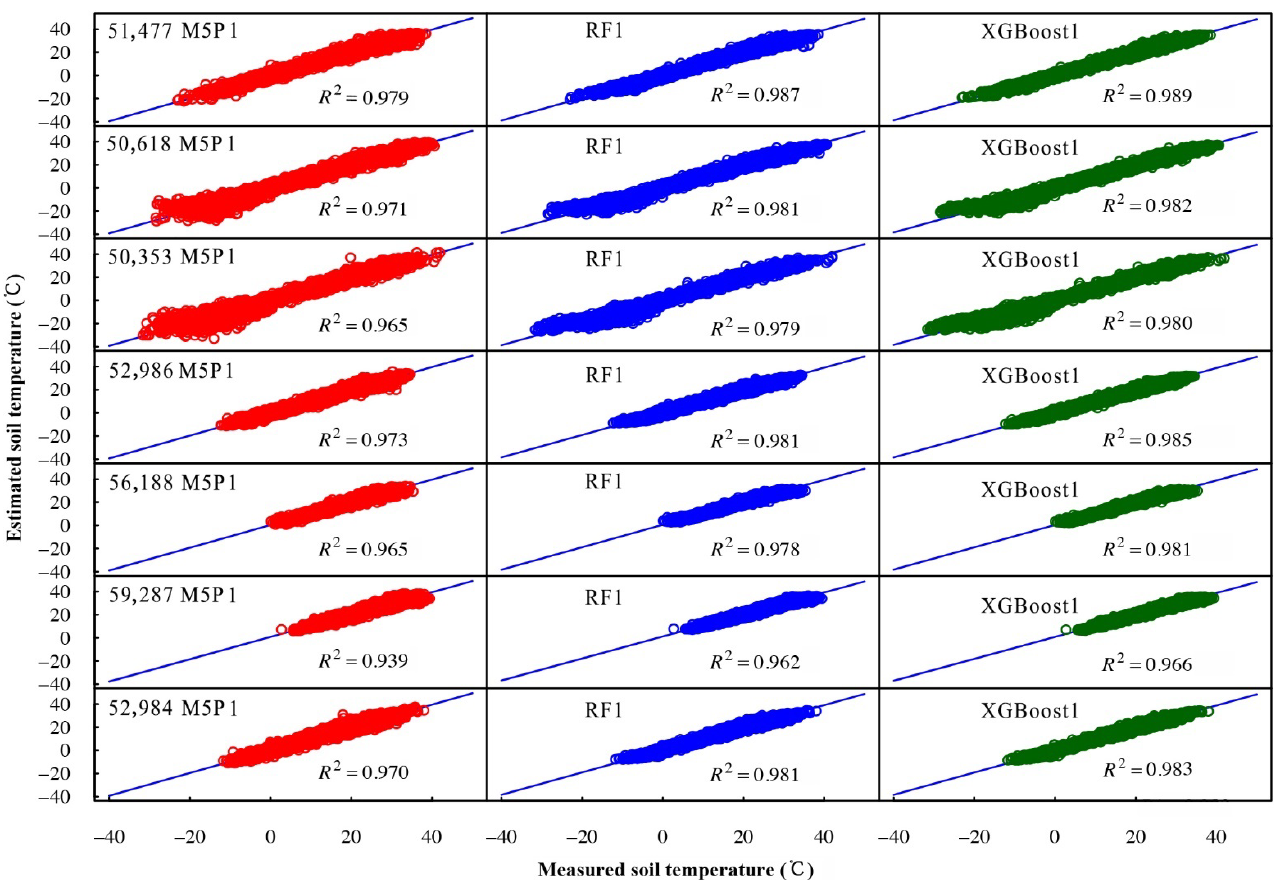
Figure 5. Scatter plot of estimated T s versus measured T s from the three machine learning models with T mean , RH, R s , and U 2 as inputs. with T mean , RH, R s , and U 2 as